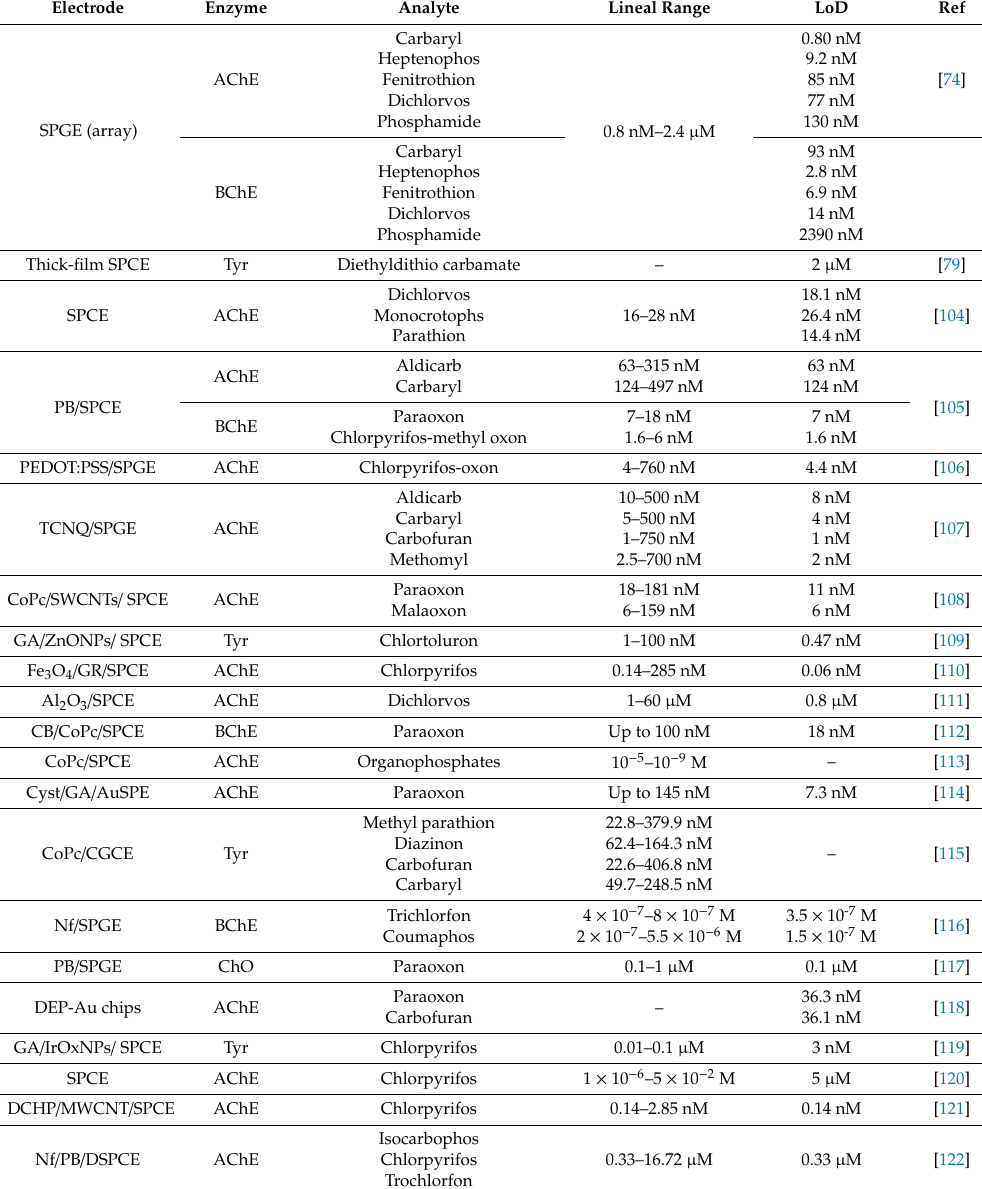
Table 1. Enzyme inhibition biosensors reported for pesticides detection on screen-printed electrodes.